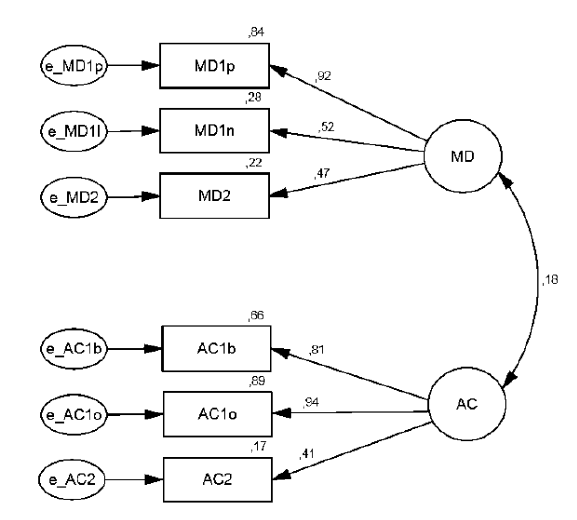
Figure 2. Three-specific factor model of the MABC-2 test –